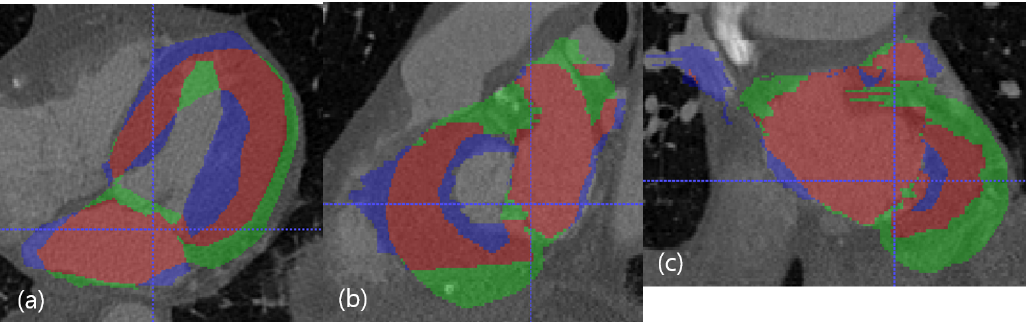
Figure 7. The worst case in the dimension of DC. The red resultant mask is true positive, the blue mask is false negative, and the green resultant mask is false positive. SSD, HD, and DC are presented as the (LV SSD, LA SSD, LH SSD, LV HD, LA HD, DC) set, which is (2.79 mm, 2.09 mm, 2.44 mm, 16.80 mm, 17.43 mm, 67.58%). ( a ) Axial view. ( b ) Sagittal view. ( c ) Coronal